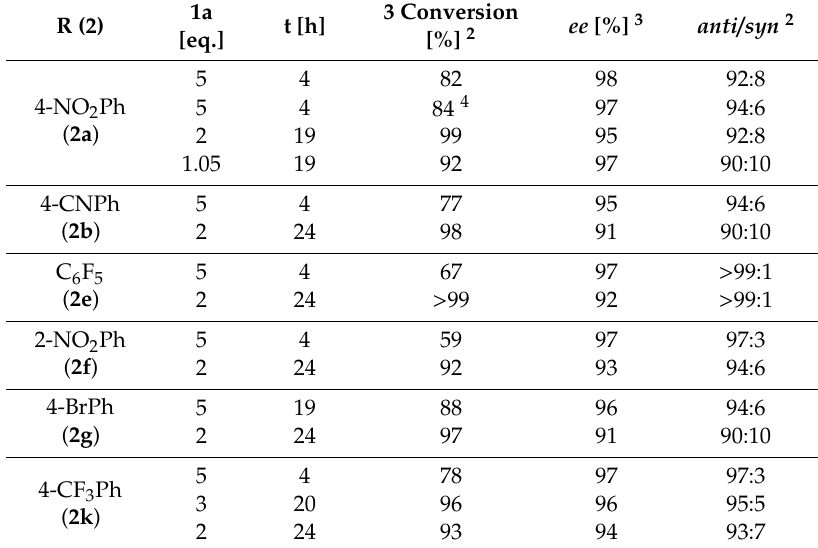
Table 4. E ff ects of cyclohexanone 1a amount in the MeOH / H 2 O / ( S )-proline-based protocol 1 .